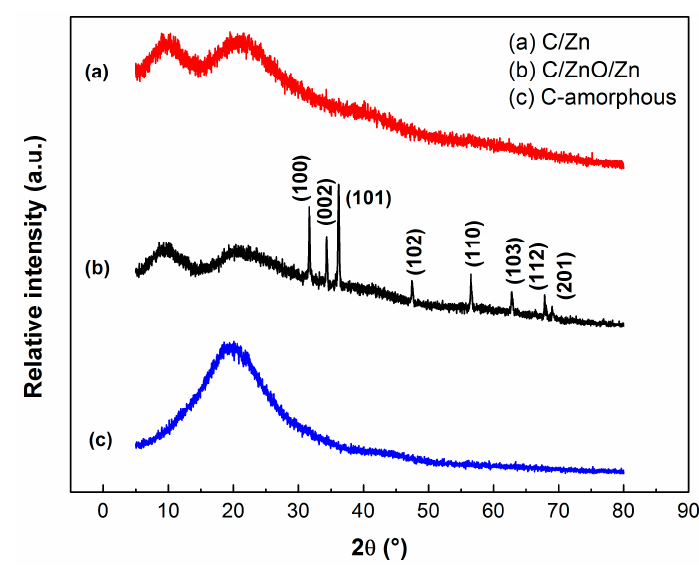
Figure 1. XRD patterns of the samples. ( a ) C/Zn; ( b ) C/ZnO/Zn; ( c ) C-amorphous.